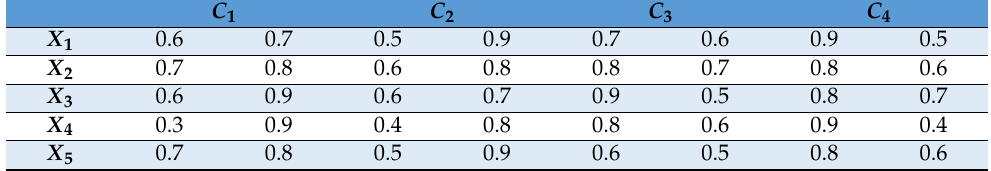
Table 5. Expert e 1 about energy resources under given criteria (after normalization).